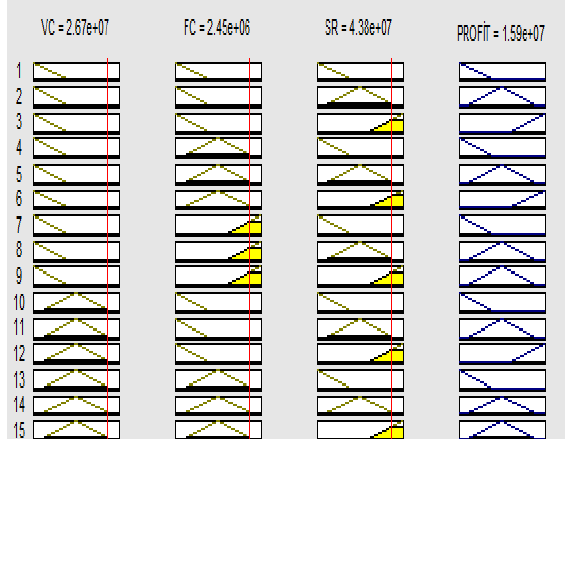
Target Costing Using Fuzzy Logic